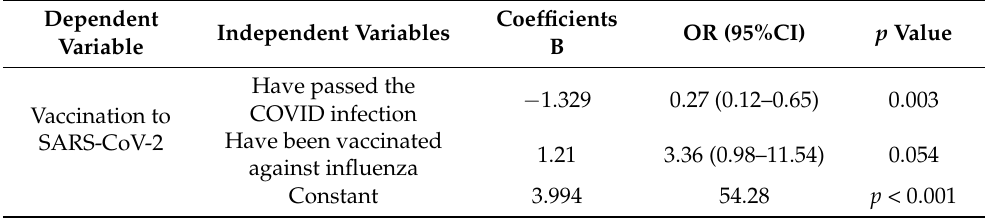
Table 7. Multivariate model using logistic regression: variables influencing vaccination coverage against